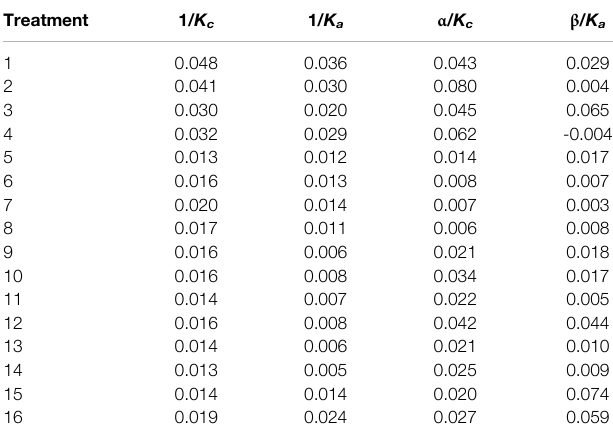
TABLE5| ParametersofChlorellavulgarisandAnabaenasp.strainPCCinLotka- Volterra Model.